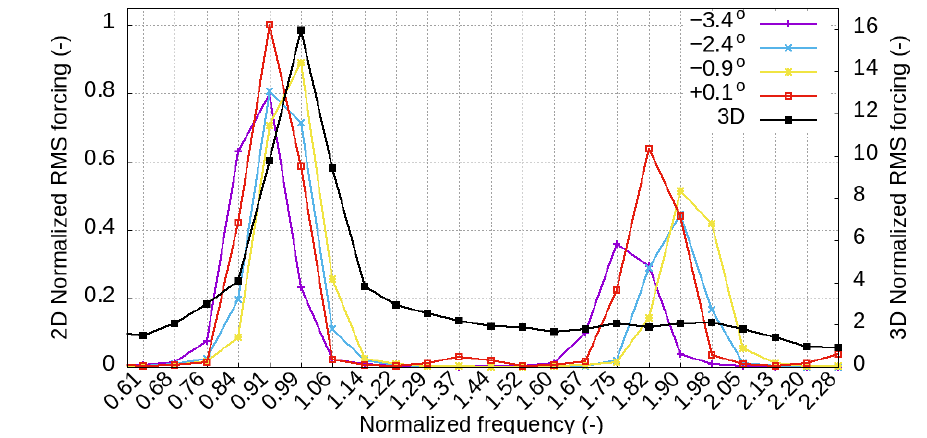
Figure 6. Parametric study forcing frequency spectra and amplitudes, varying β with constant M in